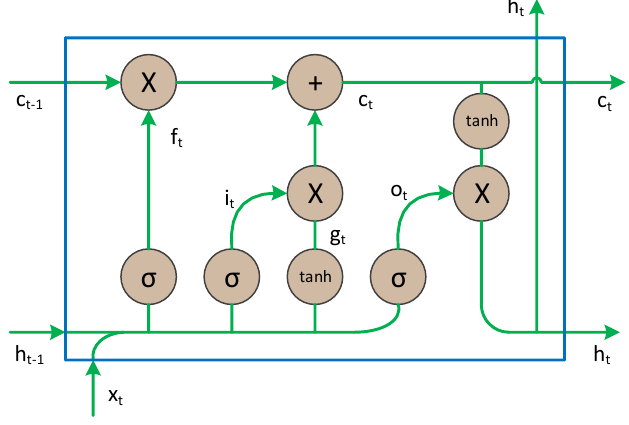
Figure 6. The structure of long short-term memory (LSTM) unit [45]. Table 3. Comparison of different LSTM inferences in the RGB stream of 8f temporal scale on UCF101 split-1.